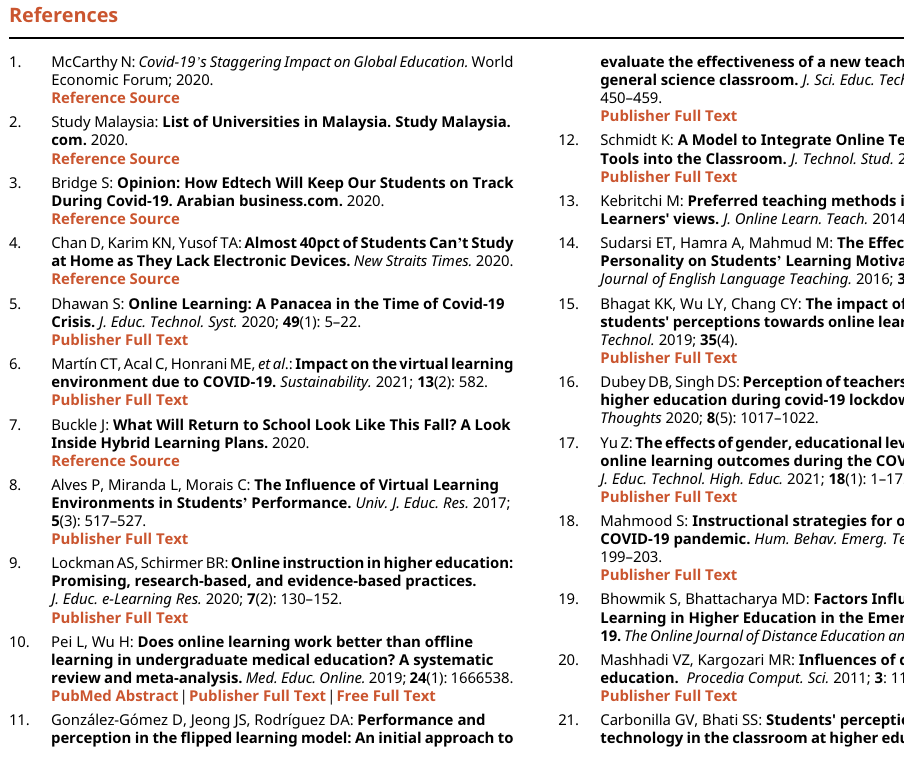
Figshare: An Empirical Study on the Impact of Virtual Learning on Multimedia University Student Performance.csv, https://doi.org/10.6084/m9.figshare.14872782.v4. 46 Data are available under the terms of the Creative Commons Attribution 4.0 International license (CC-BY